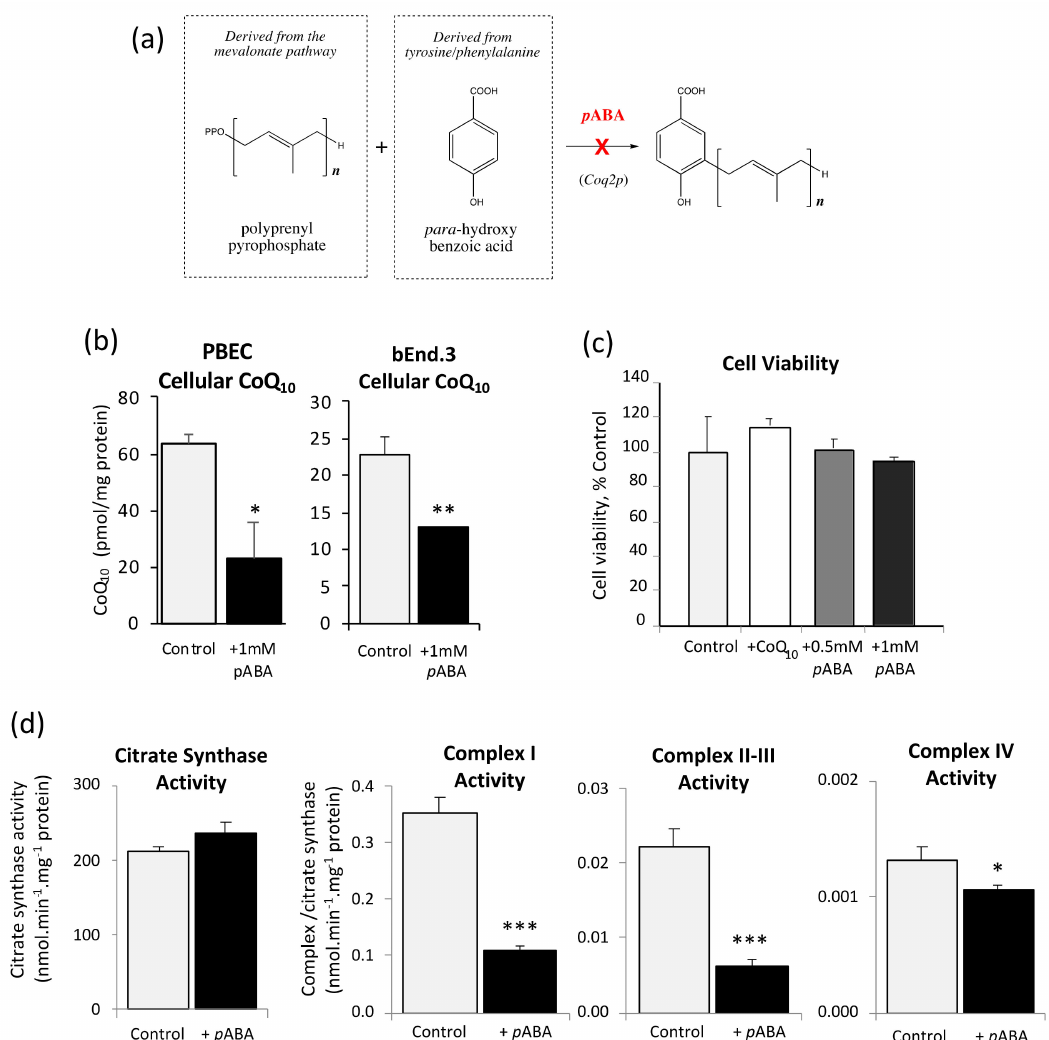
Figure 3. E ff ect of p ABA on cellular CoQ 10 content, cell viability and mitochondrial respiratory chain (MRC) complexes. ( a ) Schematic showing p ABA inhibition of CoQ 10 synthesis. ( b ) PBEC and bEnd.3 cellular CoQ 10 content after treatment with 1 mM p ABA for 5 days ( n = 4). ( c ) bEND.3 cell viability after 5 days treatment with CoQ 10 (10 µ M), or p ABA 0.5 mM or 1 mM ( n = 6). ( d ) E ff ect of 1 mM p ABA treatment for 5 days on bEND.3 MRC complex I, II, III, and IV activity and citrate synthase ( n = 4). Values are mean ± SEM; * p < 0.05, ** p < 0.01, *** p < 0.001 compared to